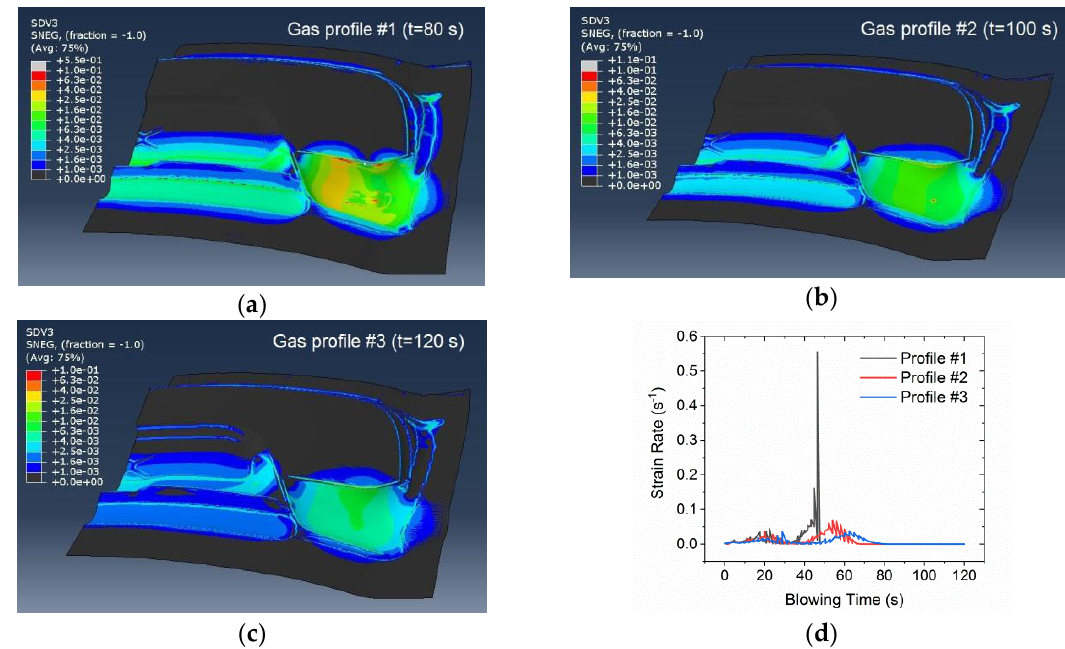
Figure 10. Predicted strain rate variation within the part at blowing time of 46 s for: ( a ) gas profile #1 ( t = 80 s); ( b ) gas profile #2 ( t = 100 s); ( c ) gas profile #3 ( t = 120 s). ( d ) Evolution of strain rate during blow forming for a selected node.